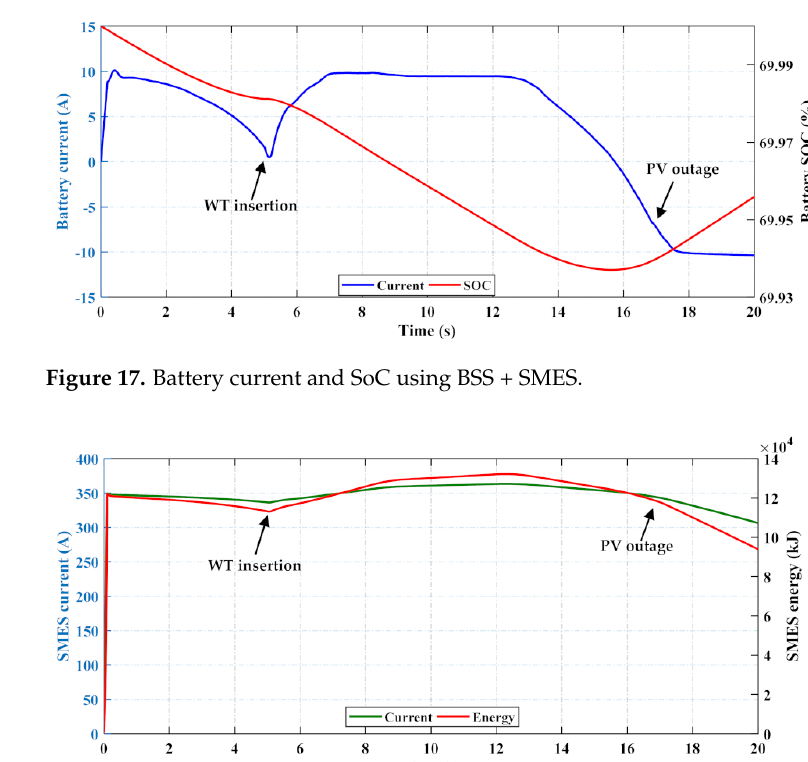
Figure 16. Battery current and SoC using battery only.